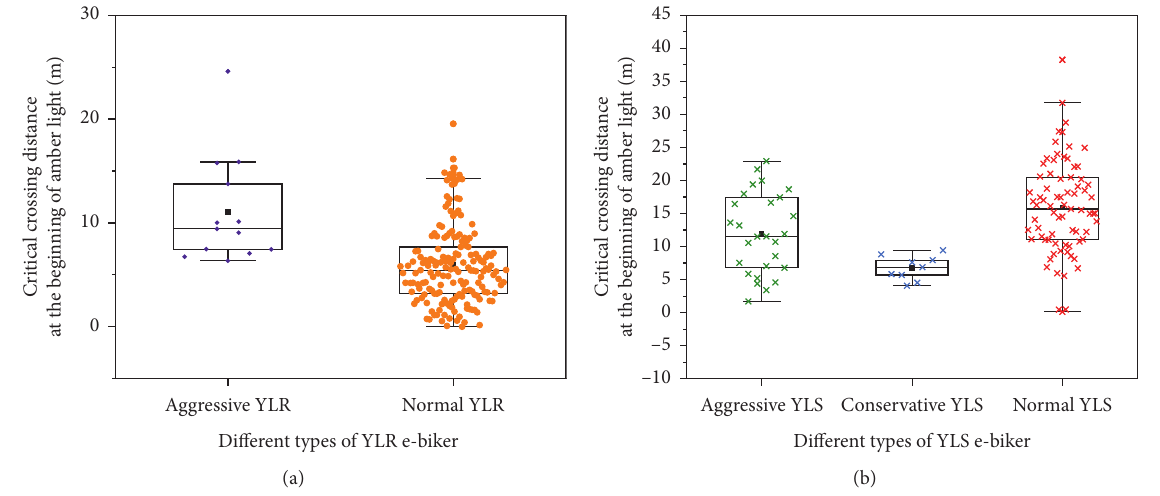
Figure 9: Box plots of critical crossing distance for different types of YLR and YLS e-bikers.